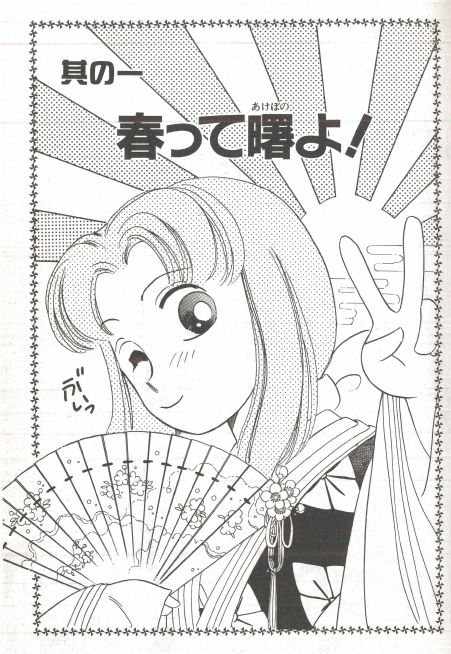
Figure 1. Sei makes a V-sign and gives a wink to the reader Mendō Kazuki, Makura no sōshi (2006), 9. (Courtesy of